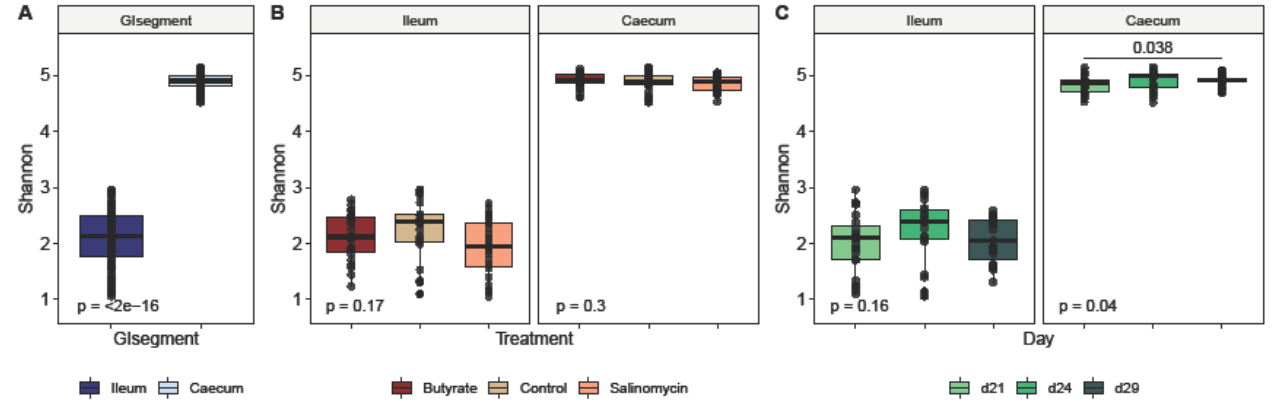
Figure 1. Alpha diversity based on Shannon Index. ( A ) GI segment effect on alpha diversity (all samples combined), ( B ) treatment effect on alpha diversity (for all ceca samples combined (left graph, see title) and all ileum samples combined (right graph, see title), and ( C ) age effect on alpha diversity (for all ceca samples combined (left graph, see title) and all ileum samples combined (right graph, see title)). P-values provided: For ( A ) differences between GI segments were identified by t -test. For ( B , C ), overall treatment and age effect, respectively, were identified using a Kruskal–Wallis test (provided in the bottom of each graph), and pairwise differences between treatment or age groups, respectively, were determined by pairwise Wilcoxon rank sum tests (provided as horizontal bars). Only significant pairwise differences are